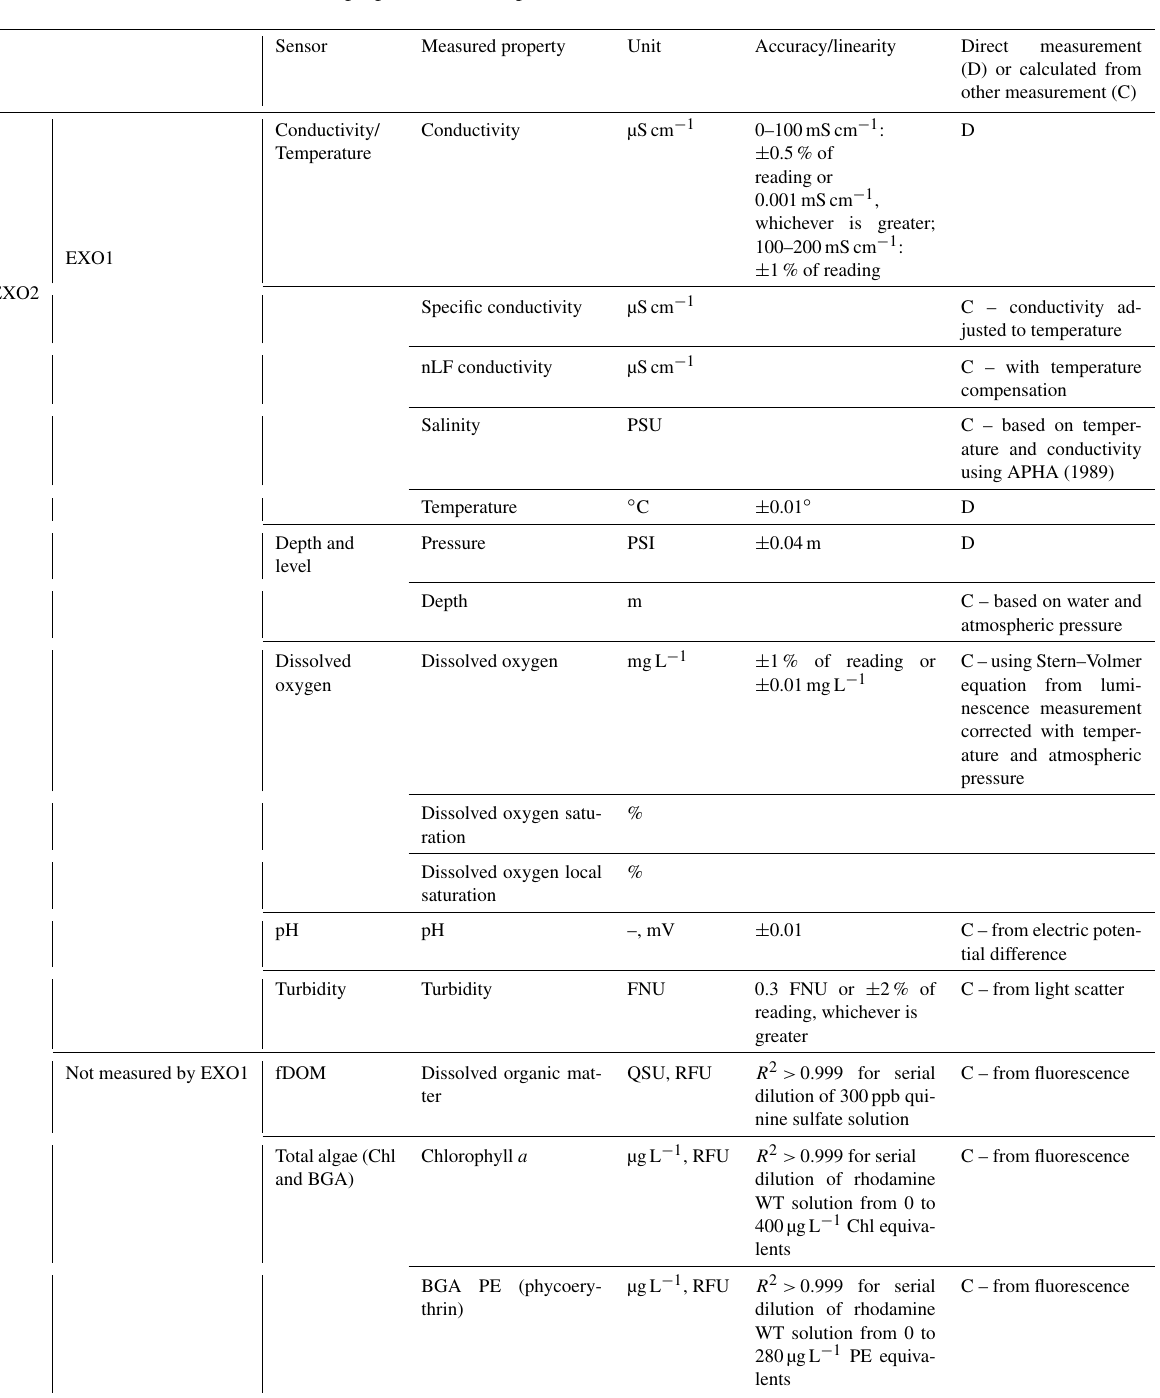
Table 2. List of sensors and measured water properties (based upon YSI Inc,